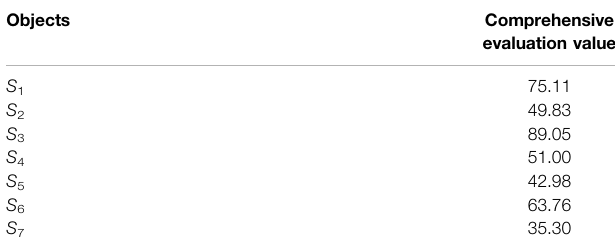
FIGURE 4 | Comparison of comprehensive evaluation results.